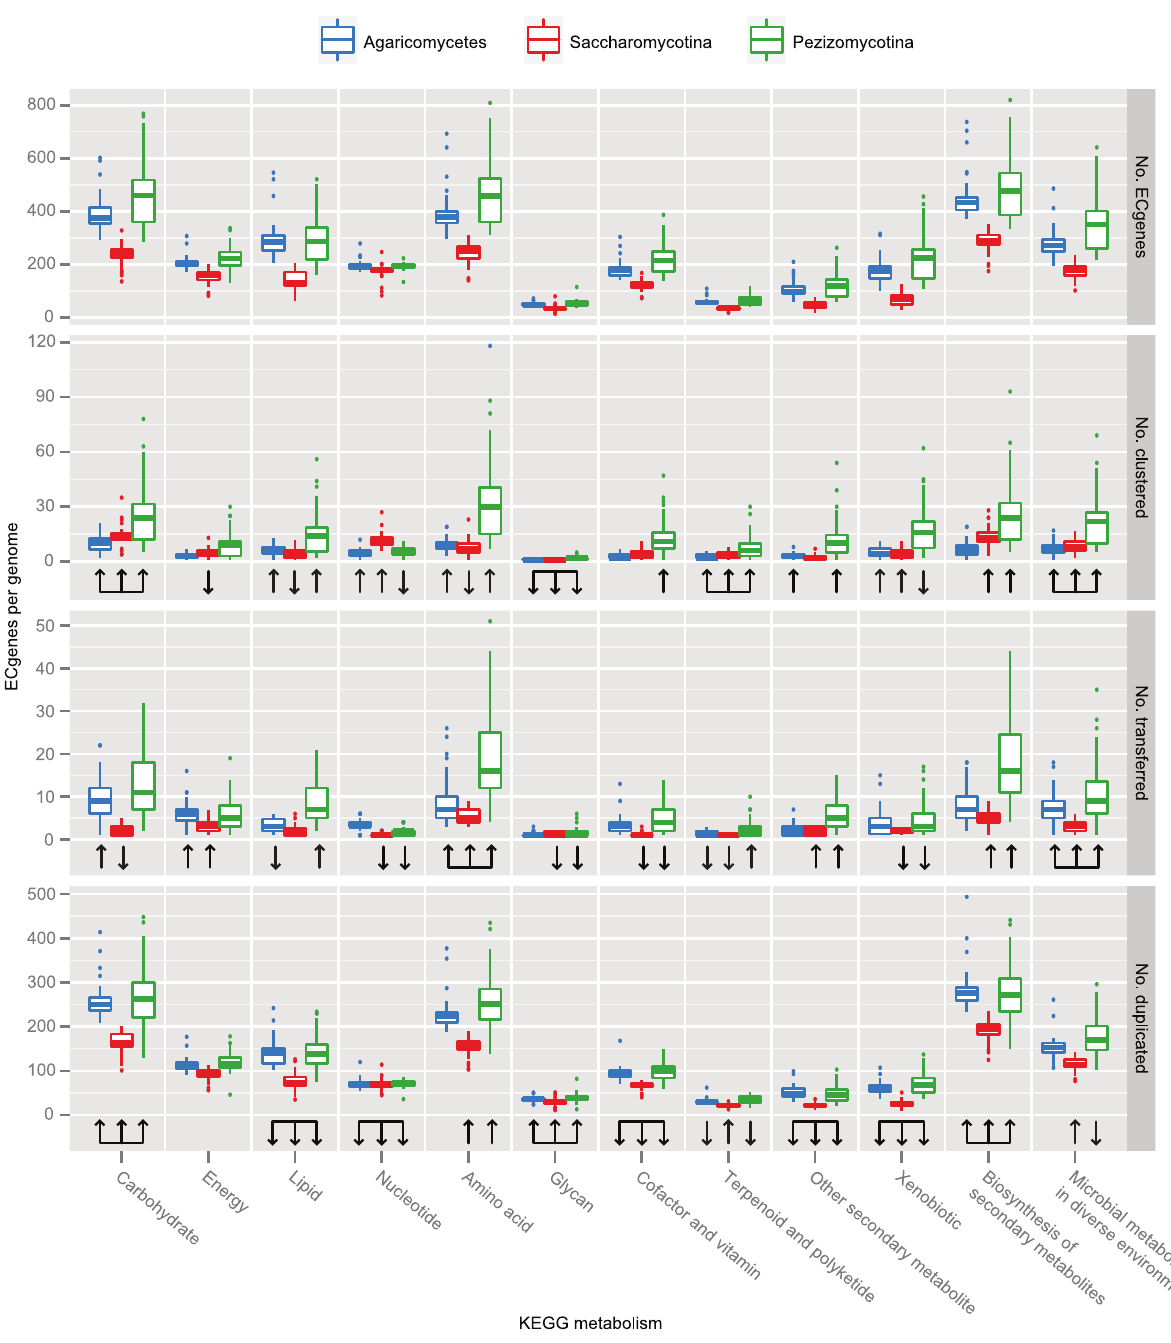
Figure 2. Over/underrepresentation of KEGG metabolic categories across three major fungal lineages. From top to bottom, the box- and-whisker plots correspond to number ECgenes per genome, number of clustered ECgenes per genome, number of transferred ECgenes per genome, and number of duplicated genes per genome. Agaricomycetes boxes are colored blue, Saccharomycotina boxes are colored red, and Pezizomycotina boxes green. Box-and-whisker convention is as described in Figure 1. Up arrows under boxes indicate overrepresentation, and down arrows indicate underrepresentation of the corresponding metabolic category in the corresponding lineage. Significance of differential representation was estimated using a two-tailed Fisher’s exact test using a Benjamini & Hochberg adjusted P value # 0.05 to account for multiple testing (Table S4).